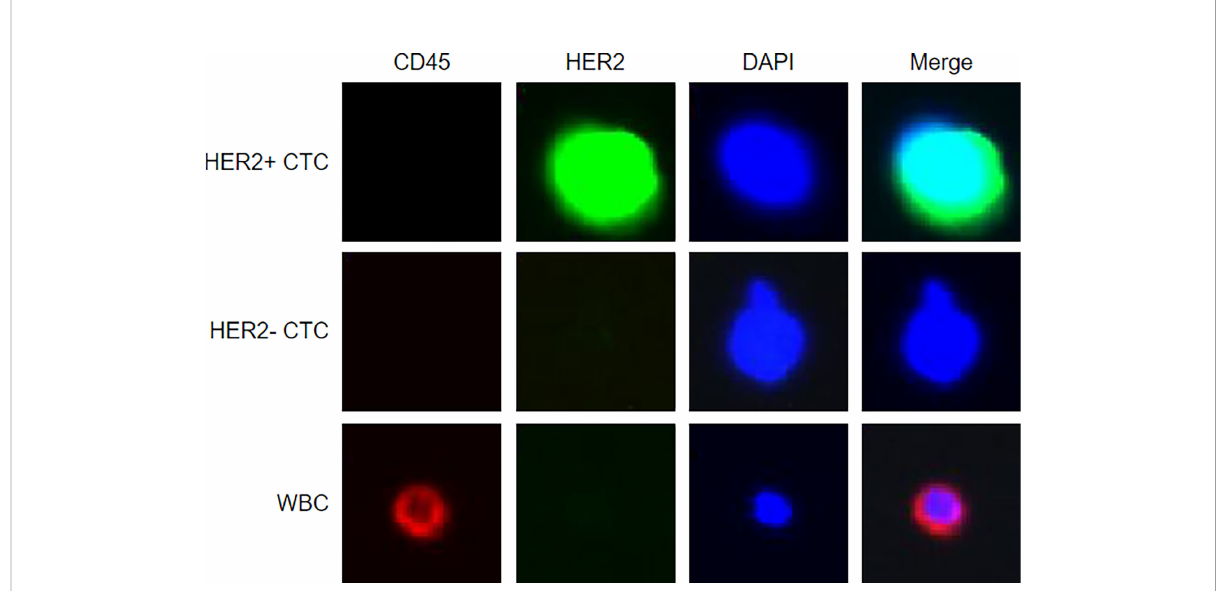
FIGURE 1 Representative fi gures of HER2+/HER2- circulating tumor cells and white blood